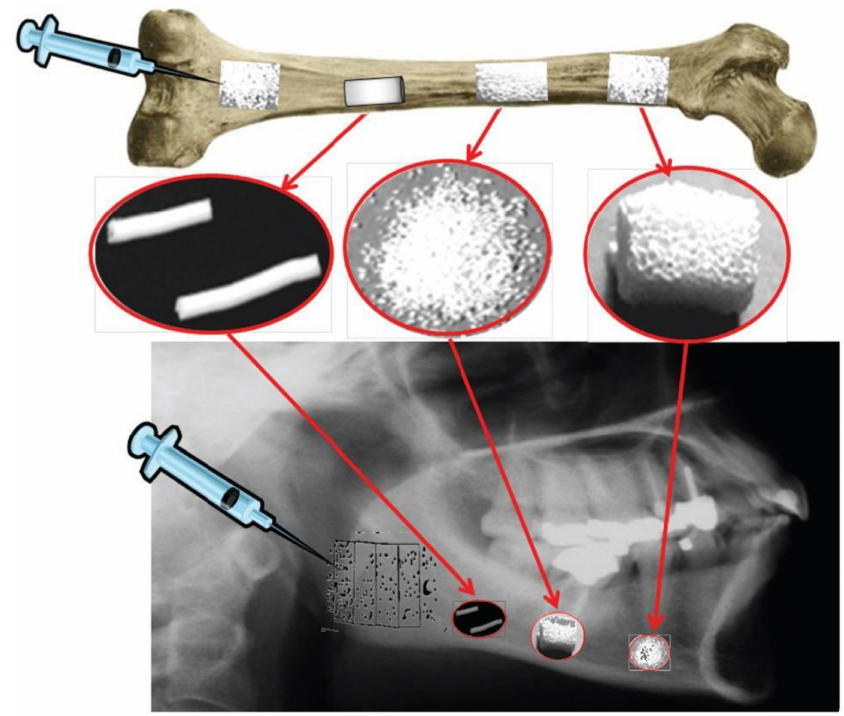
Figure 15. Different types of biomedical applications of CaPO 4 bioceramics. Reprinted from Ref. [731] with